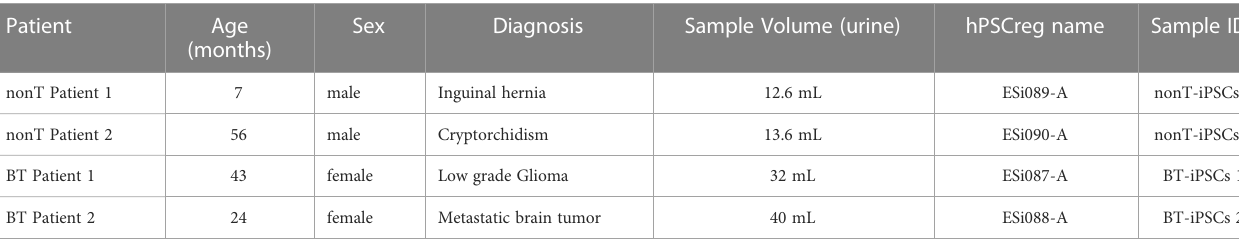
TABLE 1 Clinical characteristics of pediatric patients.